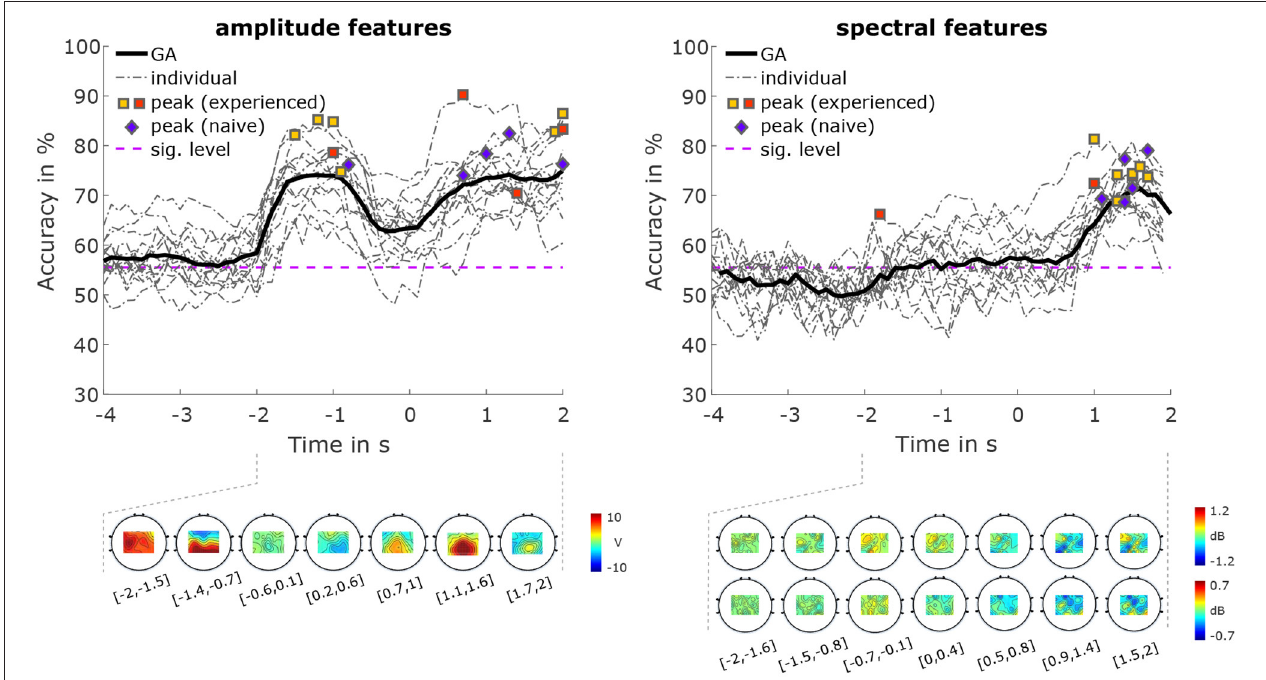
FIGURE 7 | Classification results for condition VtG vs. condition noVtG, for amplitude features (left) , and spectral features (right) . The grand-average accuracies are depicted as thick black lines, single-subject accuracies as dash-dotted dark gray lines. The individual peak accuracies are marked with squares for MI experienced participants, and diamonds for MI naïve participants, with the same color coding as in Figures 4 – 6 . Below the accuracy plots, the activation patterns of the amplitude features (bottom left), and the power feature CSPs of the spectral features (bottom right) are presented for selected time intervals within the pre-MI and MI periods.